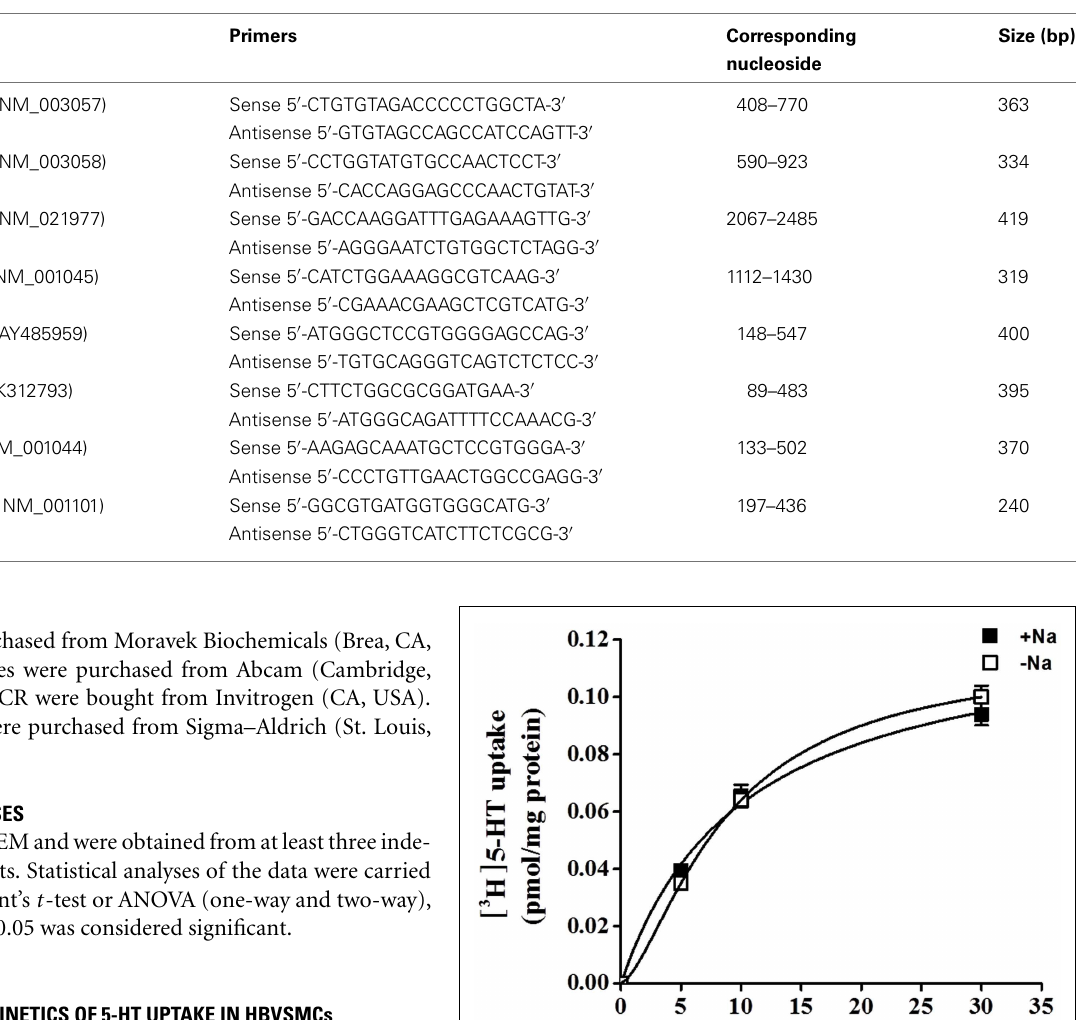
Table 1 | Oligonucleotide sequence of the primers used for RT-PCR. Primers Corresponding